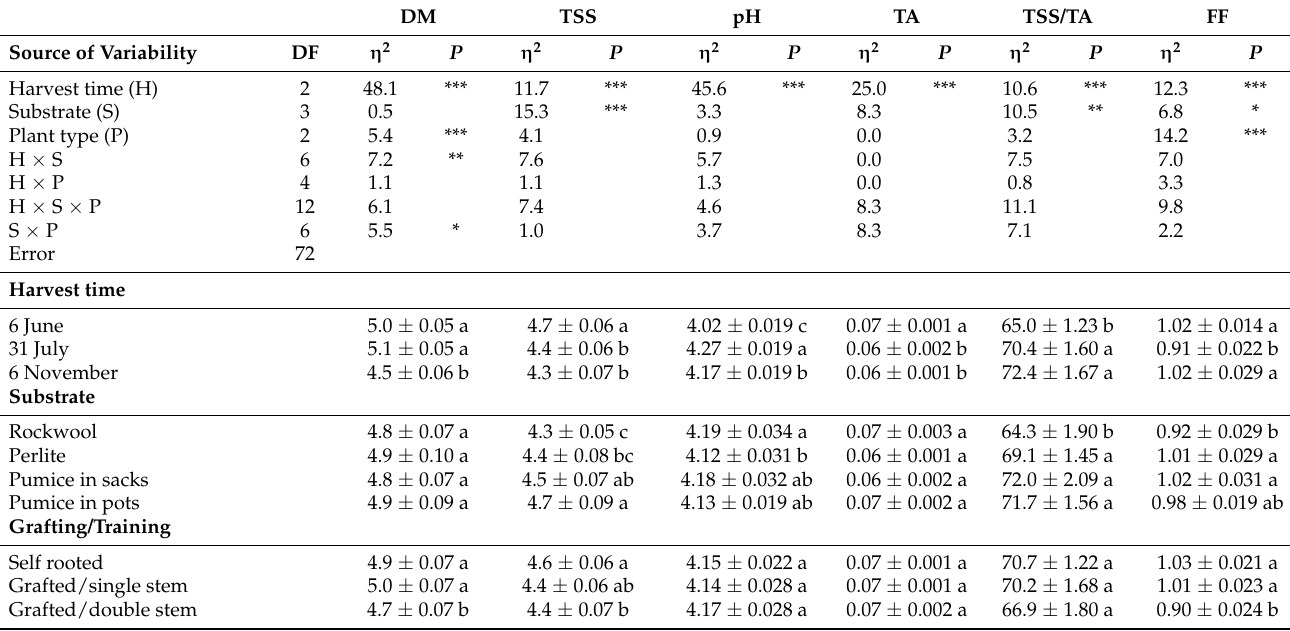
Table 2. Analysis of variance for average flavor quality traits (dry mass: DM, total soluble solids: TSS, titratable acidity: TA, flesh firmness: FF) of tomato fruit harvested at three harvest dates (6 June, 31 July and 6 November). The fruit was obtained from self-rooted ‘Beef Bang F1’ ‘Beef Bang F1’ grafted onto ‘Defensor’, trained in single or double stem and grown hydroponically in four substrates (rockwool slabs, perlite in sacks, pumice in sacks and pumice in pots) in a glasshouse. DM TSS Source of Variability